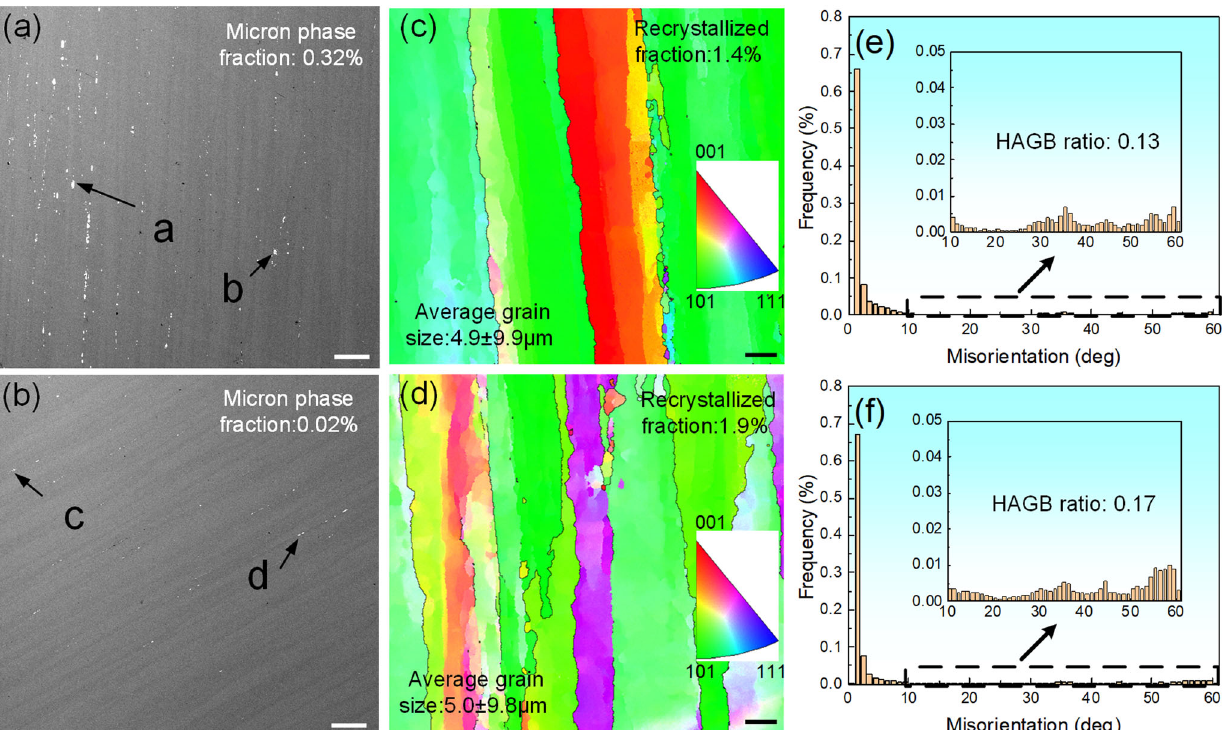
Fig. 4 The microstructure of the samples treated by the T6 process and HT0 process. a The micron secondary phase morphology of the T6 sample; b the micron secondary phase morphology of the HT0 sample; c grain structure of the T6 sample; d grain structure of the HT0 sample; e grain boundary type distribution of the T6 samples; f grain boundary type distribution of the HT0 samples.Scale bars: 50 μ m ( a , b ), 10 μ m ( c , d Table 2. Chemical composition (at%) and volume fraction (%) of micron secondary phase in the samples treated by the T6 and HT0 processes. Process